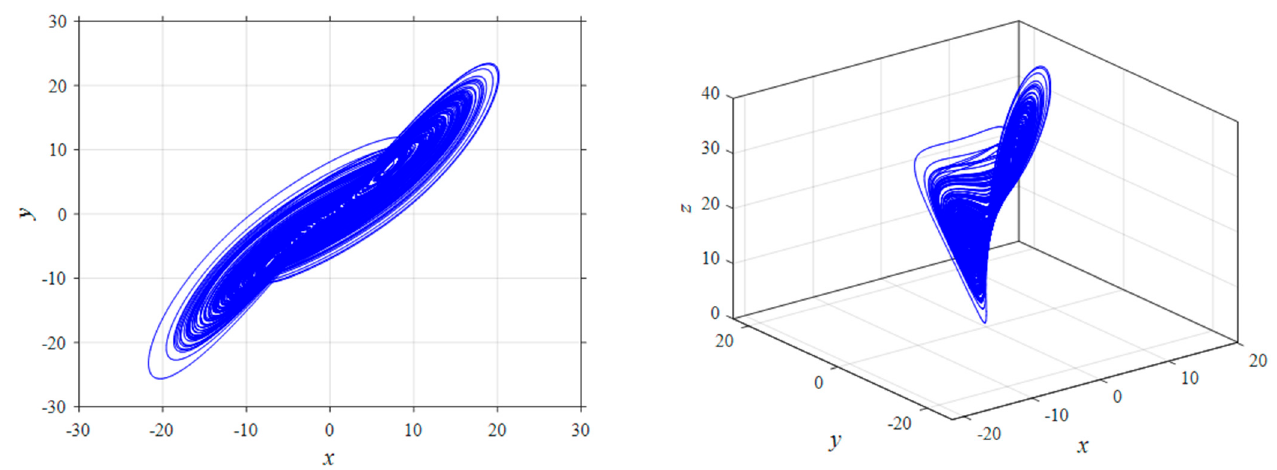
Figure 2. Fractional Chen system chaotic attractor using SINC-DQM with time ( T = 100 ) and fraction λ = 1.2, γ = 0.85, a 1 = 35, a 2 = 3, a 3 = 28, and x ( 0 ) = − 9, y ( 0 ) = − 5, z ( 0 ) =